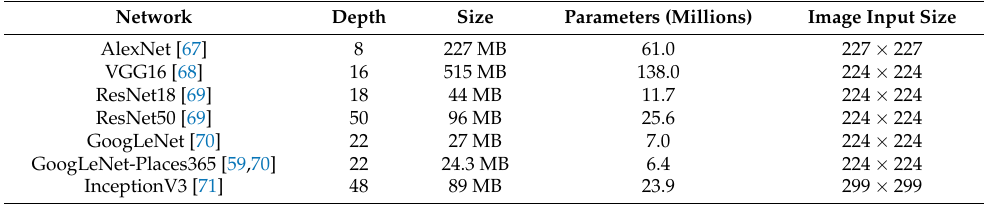
Figure 1. High-level workflow of the proposed algorithm. Temporally pooled and visual saliency weighted deep features are extracted from each video sequence with the help of multiple pre-trained CNNs independently from each other. Next, the extracted deep feature vectors are mapped onto perceptual quality scores. These scores are fused together to obtain the estimated perceptual quality of the input video sequence. Table 1. Applied pre-trained CNN architectures and some of their main